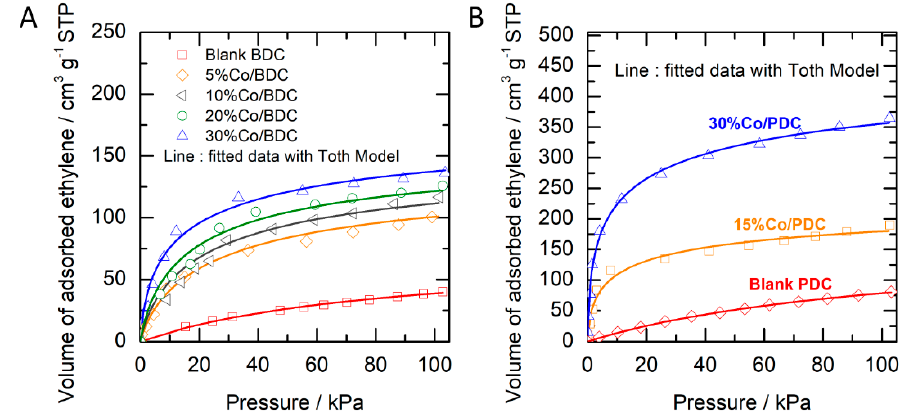
Figure 3. Adsorption isotherm of ethylene on cobalt oxide-impregnated porous carbon (data fitted with the Toth model). Case of carbon support: biomass-derived carbon ( A ) and polymer-derived carbon ( B ). Case (A) data taken from [10].